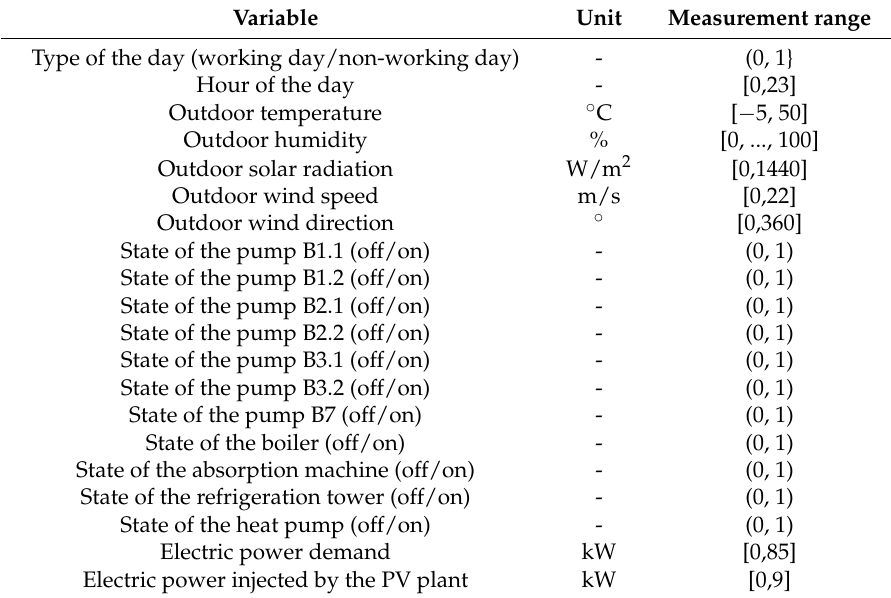
Figure 3. Weekly energy demand profiles for each season. Table 2. Preliminary list of variables [17].